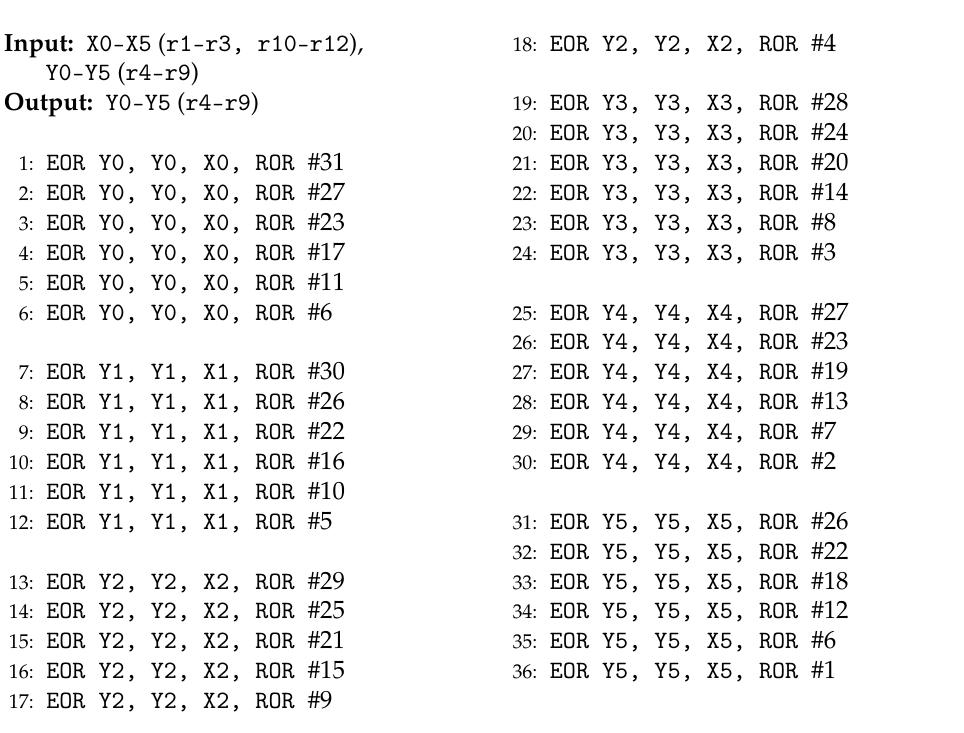
Algorithm 4 Bit-slicing implementations MixColumns in ARMv6